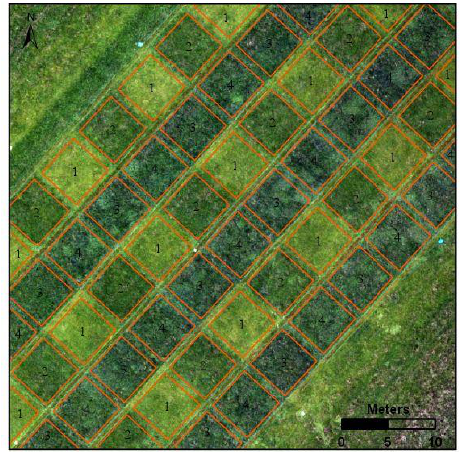
Figure 3. Detailed view of Sony Alpha 6000 based orthomosaic. Numbers inside polygons indicate treatments.